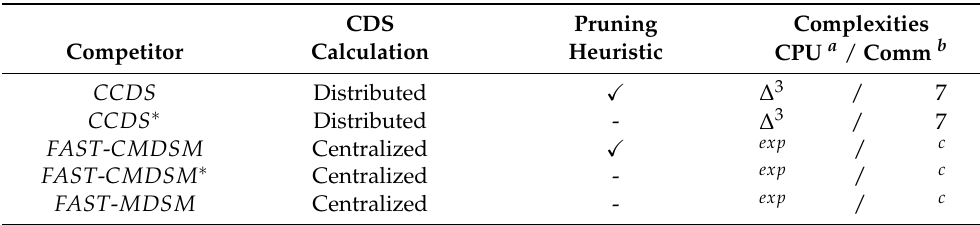
Table 1. Competitor